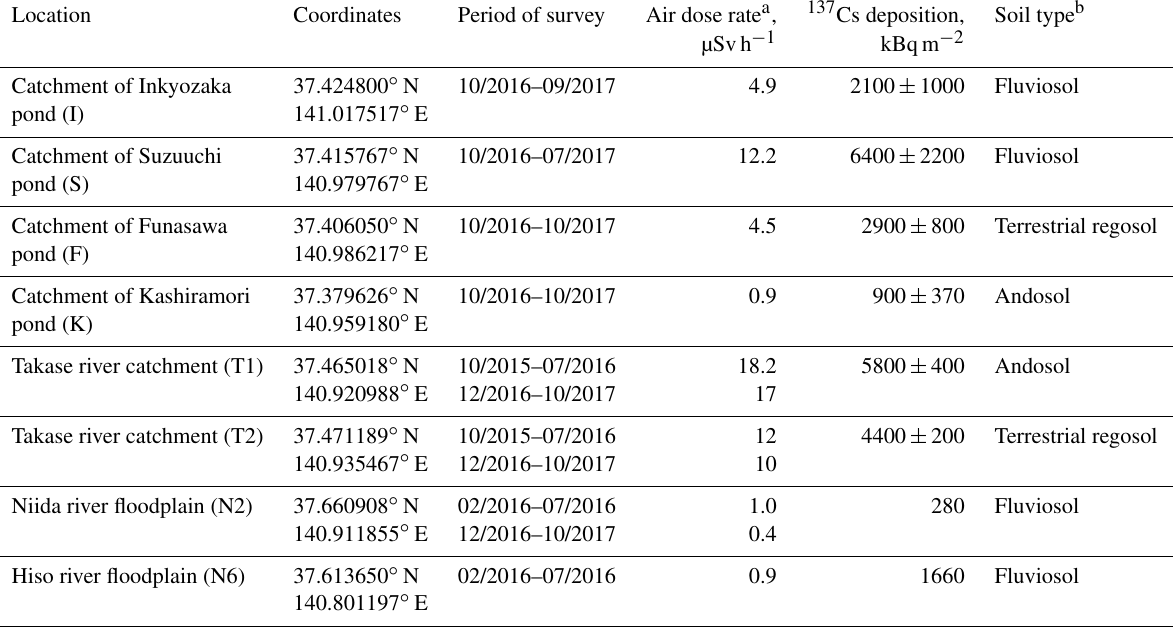
Table 1. Description of survey sites. The date format is